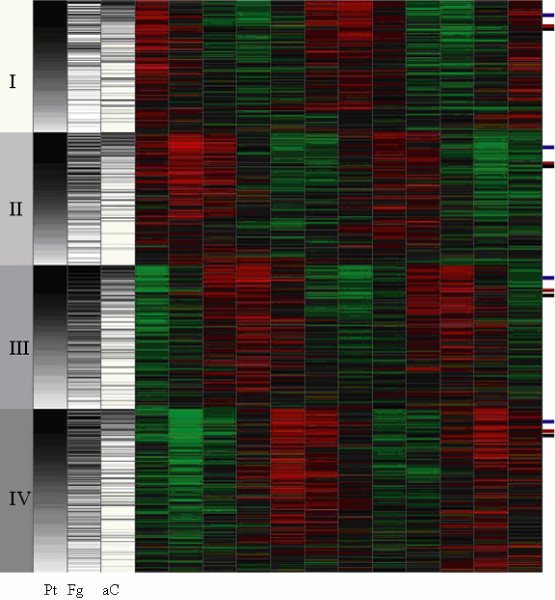
Summary of the microarray analysis of circadian periodicity and phase in murine liver. The Roman numerals represent the grouping of all expressed genes based on the calculated circadian phase, displayed in circadian time. The gray shades of first 3 columns display the p-value ranging from 0 (black) to white (1). After phase assignment in each of four phase classes the non-randomness of periodic pattern is assessed by 3 different algorithms: Permutation test developed at PBRC (Pt), Autocorrelation (aC) and Fisher's g-test (Fg). When sorted by permutation test (Pt) p-value other algorithms generally agree with the permutation test selection, but offer less sensitivity. Out of over 22,690 genes presented on this heat map over 5400 (23.8%) are expressed with circadian periodicity above p < 0.05 cutoff as estimated by at least one of three algorithms. Tickmarks on the right side mark the 0.05 cutoff for 3 algorithms (Pt-test-black, Fg-test -blue, aC-red).